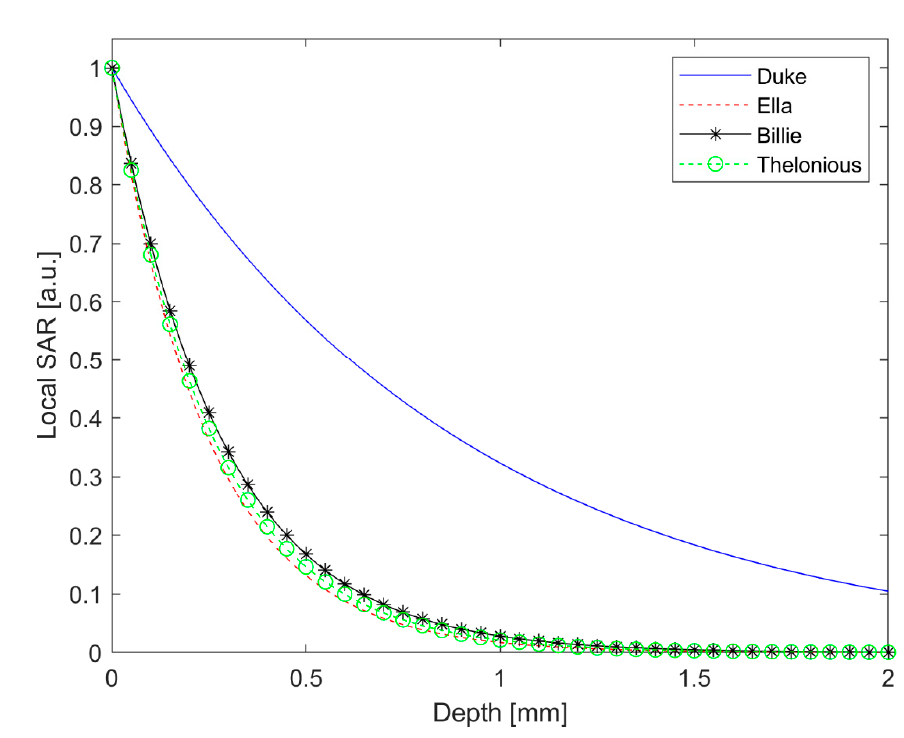
Figure 5. Local SAR (a.u.) for the first 2 mm depth in the head.